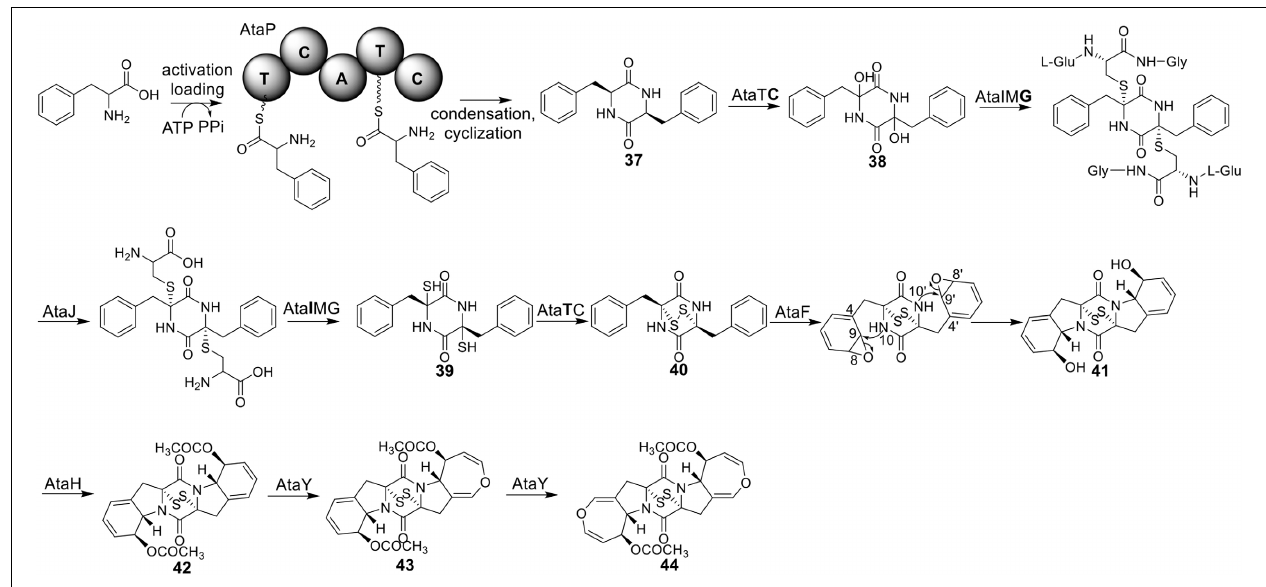
FIGURE 8 | Biosynthesis of acetylaranotin in A. terreus .